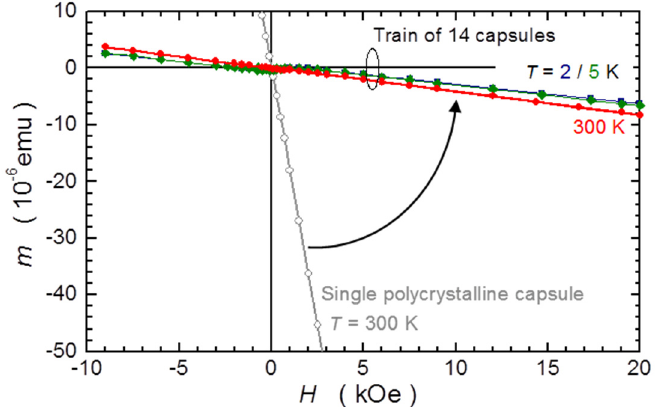
Figure 11. An example of the magnetic field H dependence of magnetic moment m for a single polycrystalline capsule (grey circles) and of the in situ compensated case of a train of nearly identical capsules loaded and stabilised in a S2 straw having its diameter reduced below the external diameter of the capsules (navy, green, and red symbols). The arrow indicates the reduction of the magnetic signal of the capsule due to the compensation effect of the neighbouring capsules.